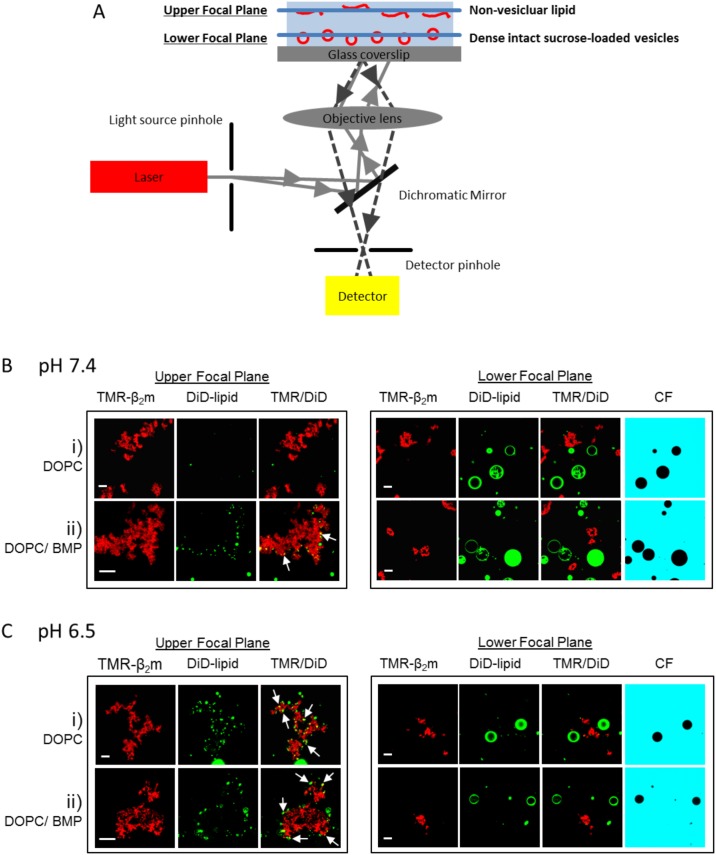
Confocal fluorescence microscopy of GUVs upon addition of fragmented β2m fibrils.(A) Confocal images were collected in two different focal planes. The upper plane contains mainly non-vesicular lipid while dense, intact sucrose-loaded GUVs are observed mostly in the lower focal plane. Confocal images of TMR-labeled β2m fragmented fibrils incubated with DiD-labeled GUVs for 15 min at ambient temperature in (B) Assay Buffer at pH 7.4 or (C) Assay Buffer at pH 6.5. (L-R) TMR-labeled β2m fibrils (red), DiD-labeled GUVs (green), superimposition of the TMR and DiD channels. Soluble CF added to the vesicle exterior is shown in blue (lower focal plane only). Representative images when viewed in the upper focal plane and lower focal plane are shown for GUVs comprised of (i) 100 mol % DOPC or (ii) 80 mol % DOPC plus 20 mol % BMP. White arrows highlight areas of lipids bound to fibril aggregates. Scale bar 10 µm.